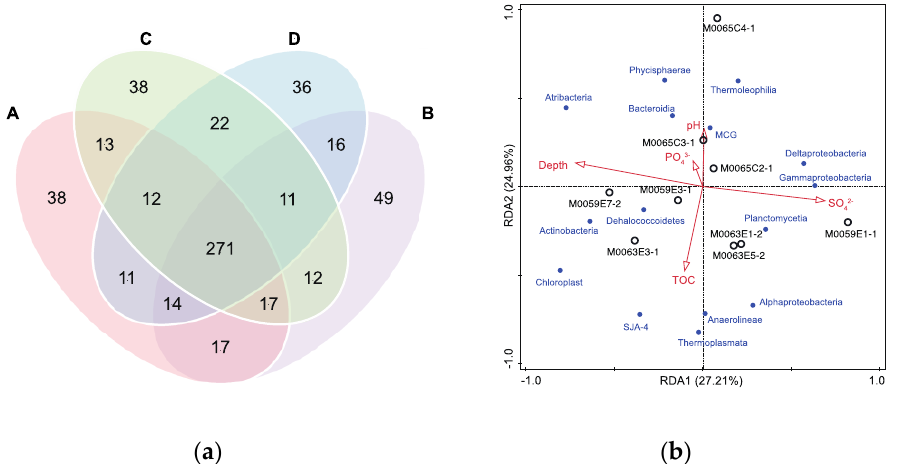
Figure 6. ( a ) Venn diagram displaying the number of unique and shared genus for different combi- nations of grinding beads. ( b ) Redundancy analysis of ASV abundance constrained by the depth, TOC content (%), pH, concentrations of SO 42 − (mM) and PO 43 − (mM). Black labels indicate samples from different boreholes, blue labels indicate dominant taxa at the class level.